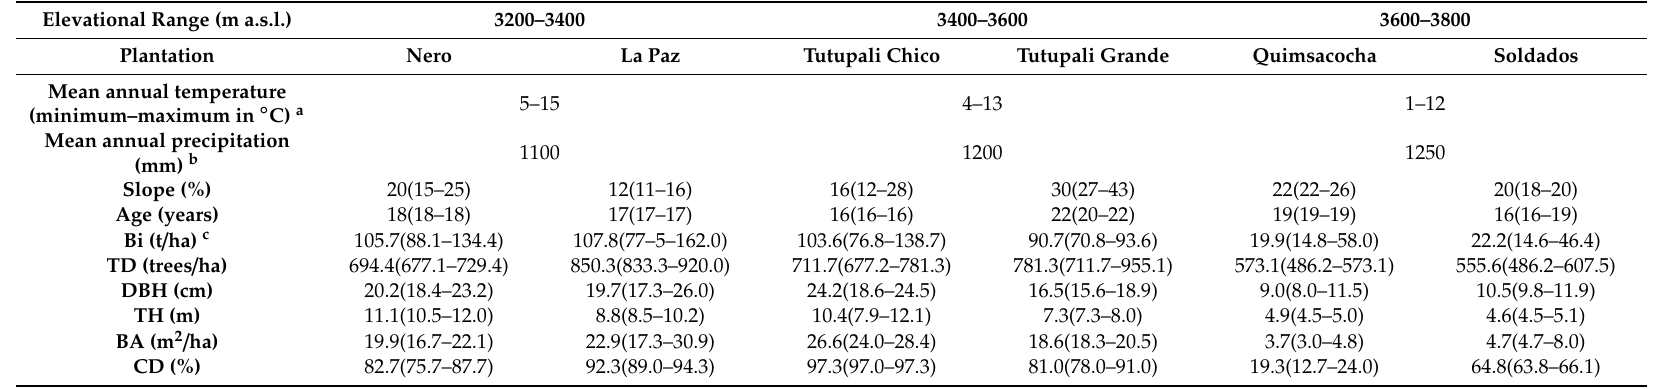
Table 1. Characteristics of pine plantations across the elevational range in the study area. Except for temperature and precipitation, all variables include the median and, between parentheses, the quartiles Q1 and Q3. Bi = pine biomass, TD = tree density, DBH = diameter at breast height, TH = tree height, BA = basal area, CD = canopy